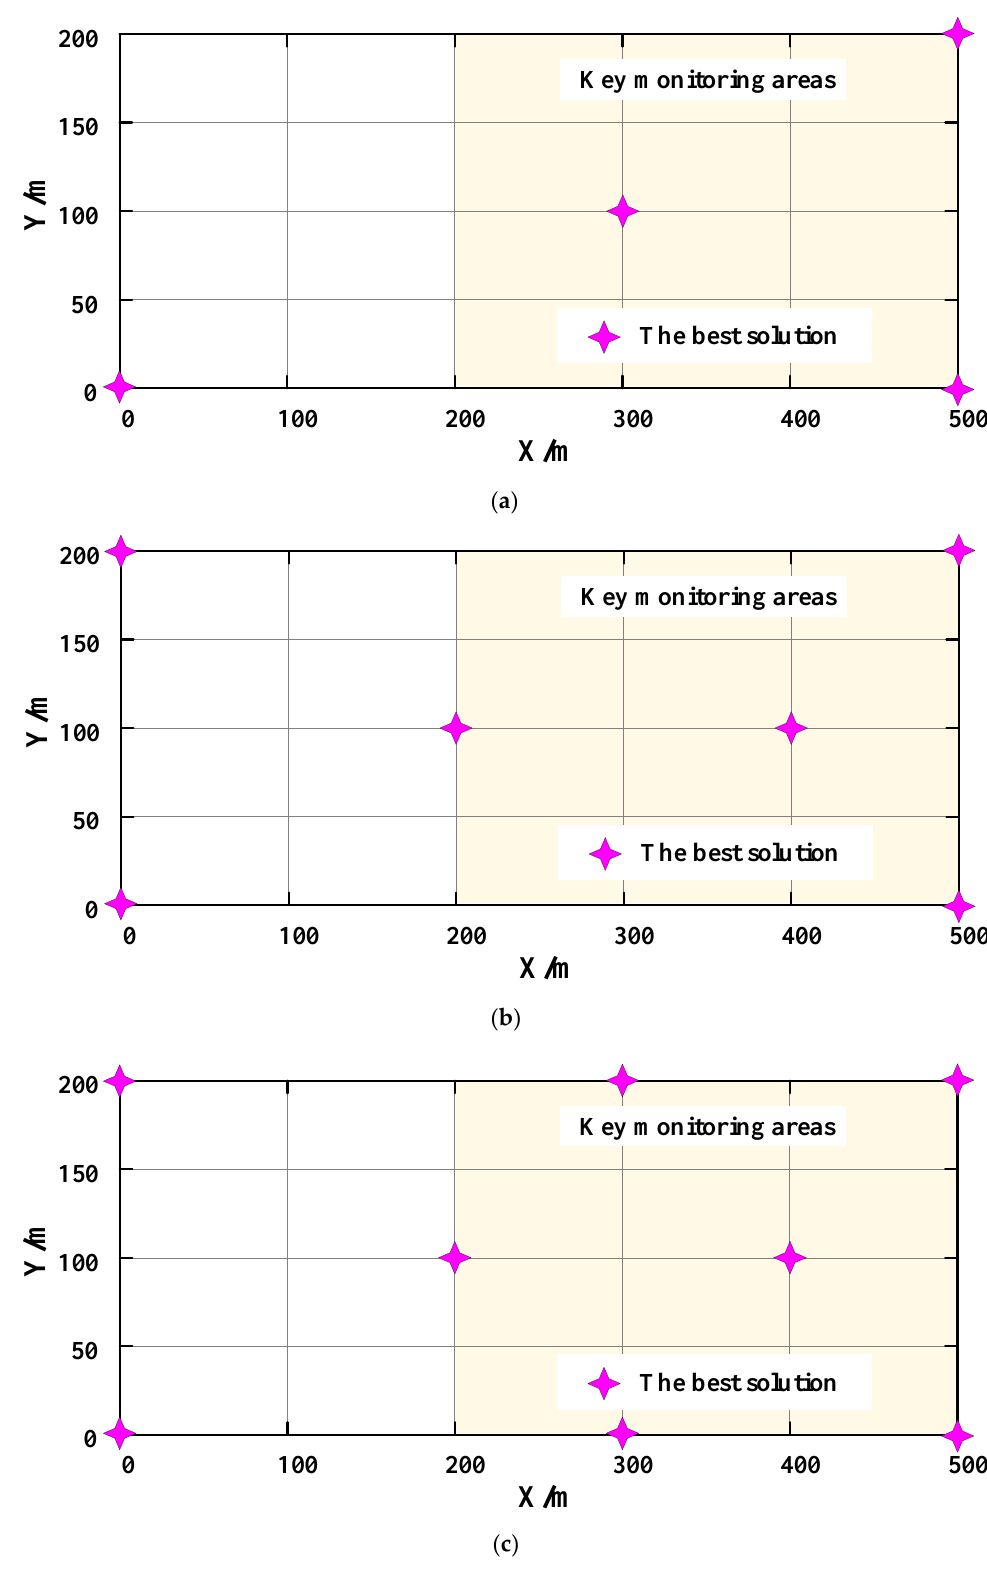
Figure 3. Network configuration results solved by EA. ( a ) Solution Results of Scheme II. ( b ) Solu- tion Results of Scheme II. ( c ) Solution Results of Scheme III.